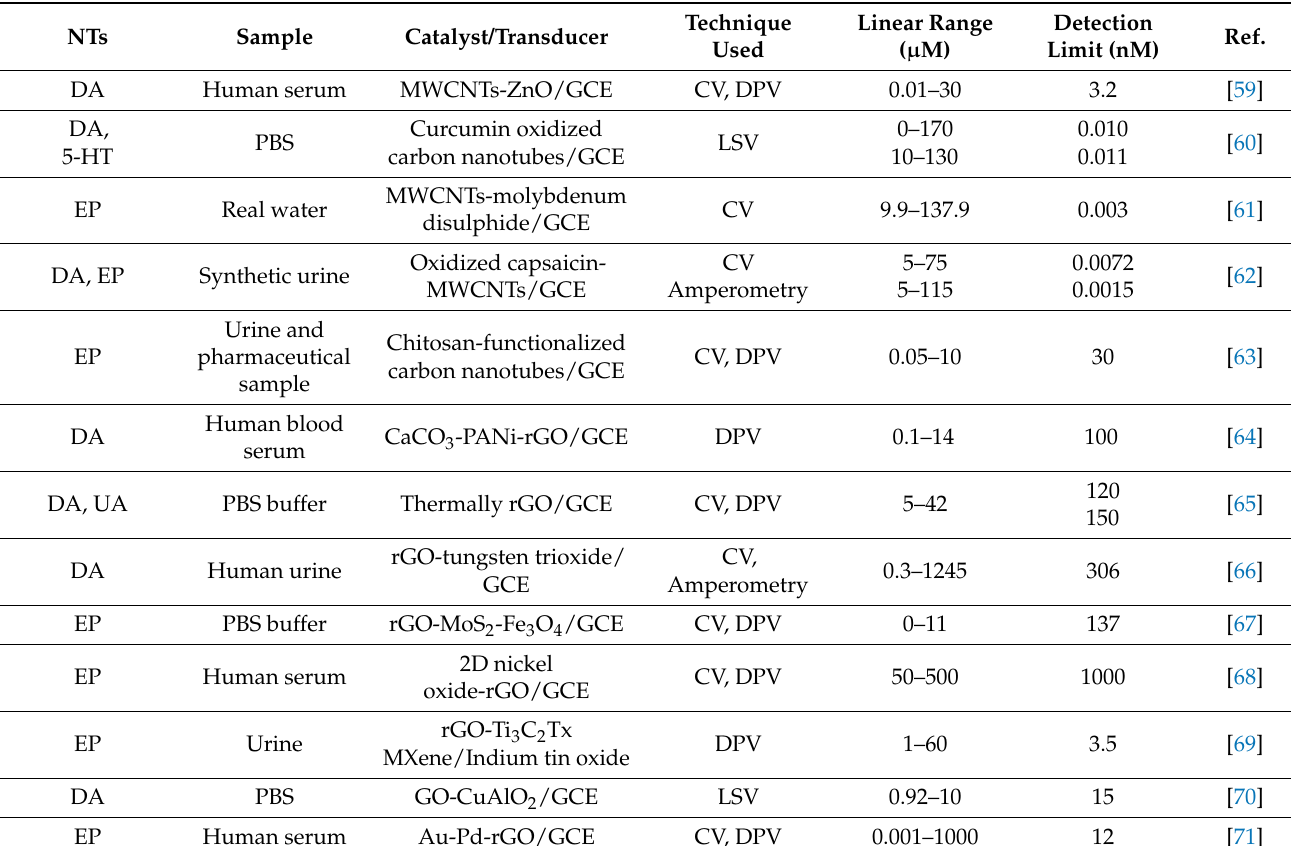
Table 1. Comparison of electrochemical catecholamines sensor-based carbon nanomaterials and its